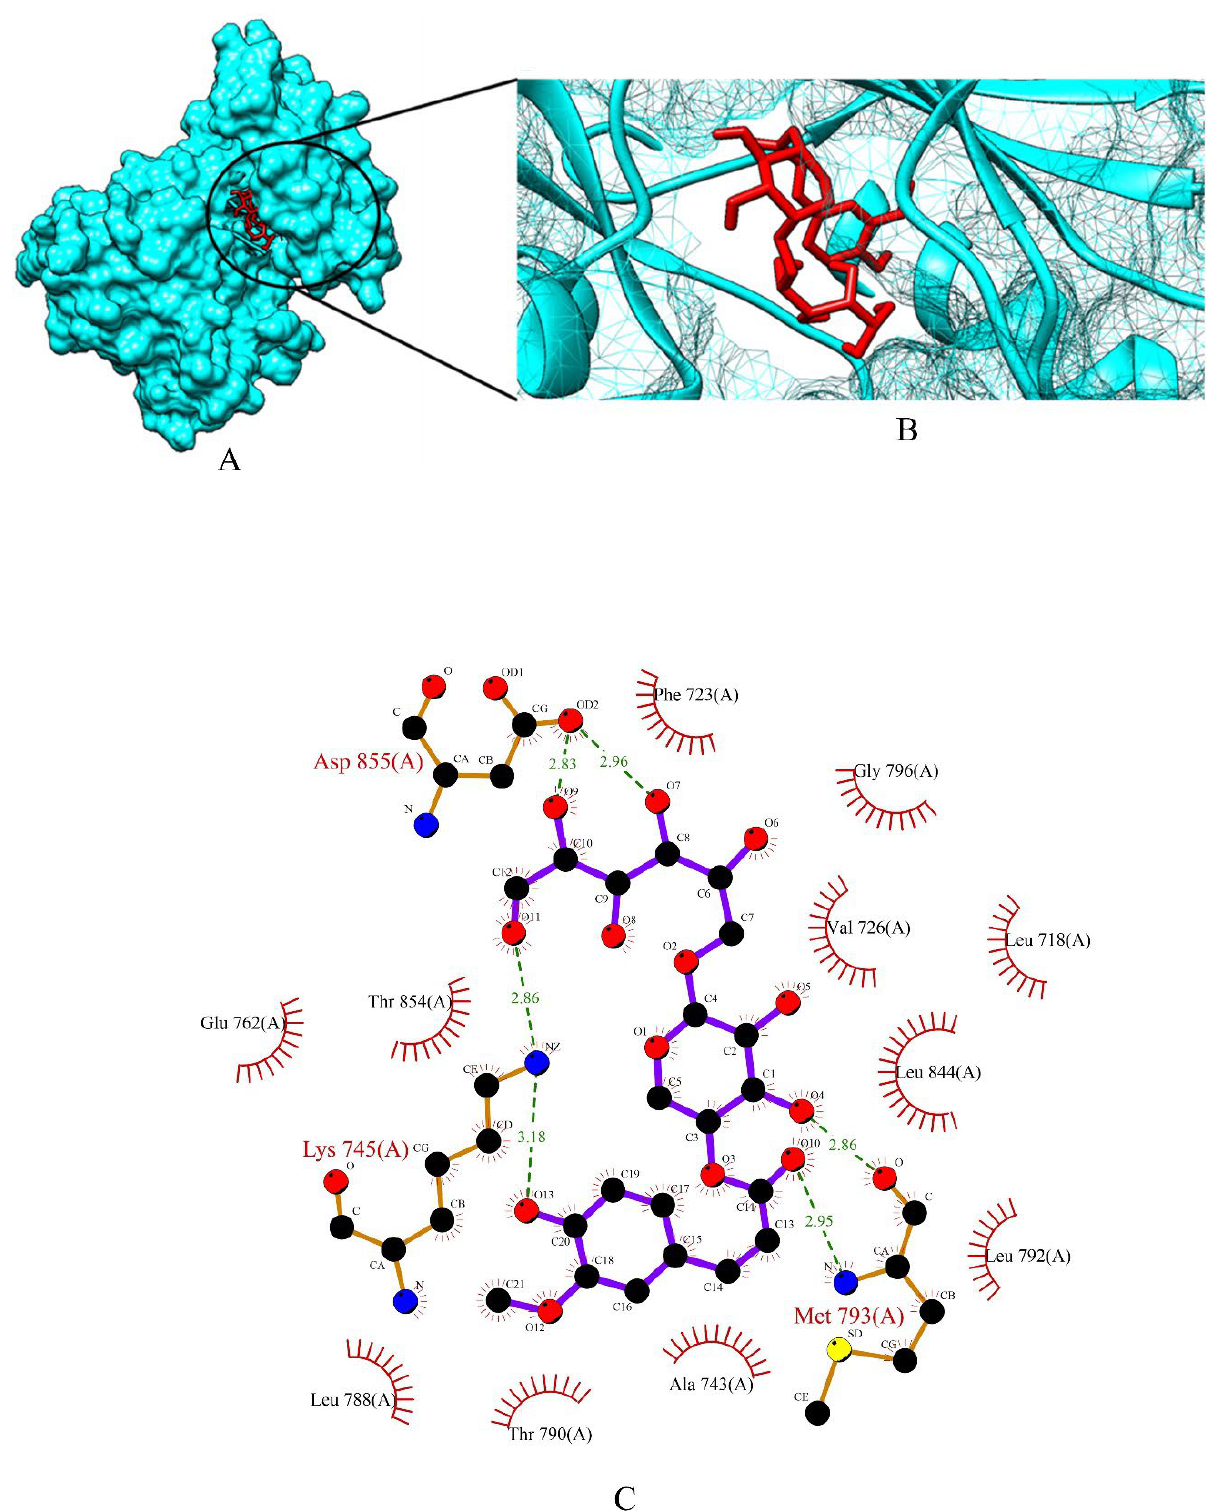
Figure 12. ( A ) Surface view of xyloglucan-EGFR binding complex. ( B ) Binding pose of xyloglucan. ( C ) Visualization of the docked complex with ligplot + shows the binding interaction of xyloglucan with EGFR. Six hydrogen bond interactions (green dotted lines) were formed by xyloglucan involving three amino acid residues (Lys 745, Met 793, Asp 855) of the target protein. Several approaches to treat breast cancer include surgery, chemotherapy, immuno- therapy, gene therapy, and protein therapy [32]. As we have mentioned earlier, the costs of conventional cancer-therapy are too expensive, making it difficult for people in low-